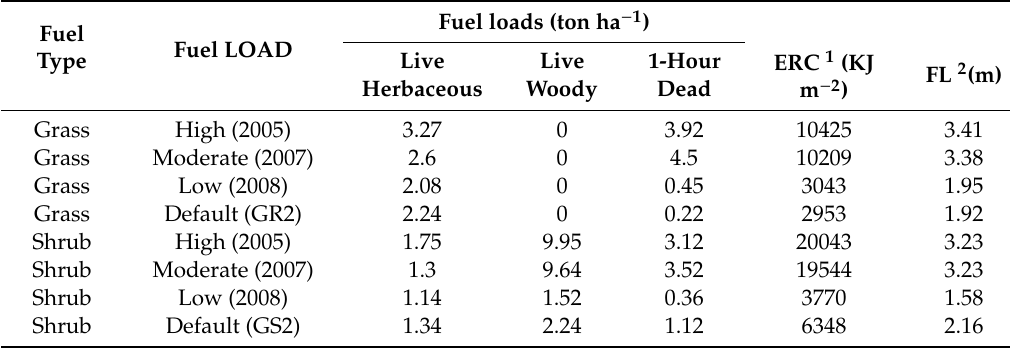
Table 1. Fuel load values and simulated fire behavior indices for di ff erent fuel load